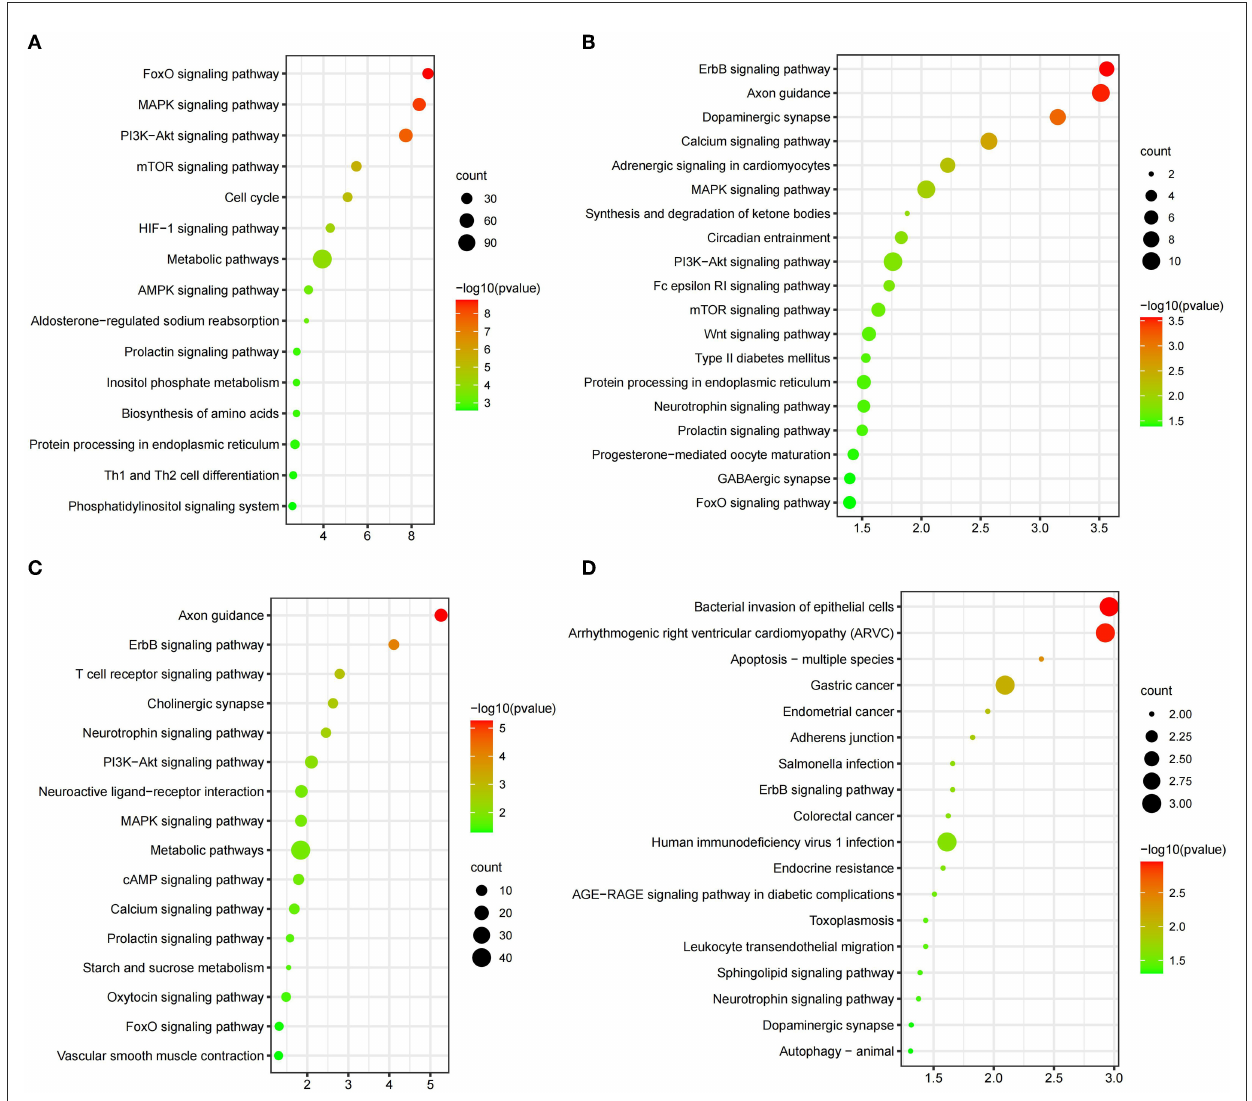
FIGURE3 KEGG pathways from the enrichment analysis. (A) CDM vs. YB; (B) CDM vs. MG; (C) CDM vs. XZ; (D) CDM vs. HSK) ( p < 0.05). We preferred showing part of the pathways; for more information, please see Supplementary Tables